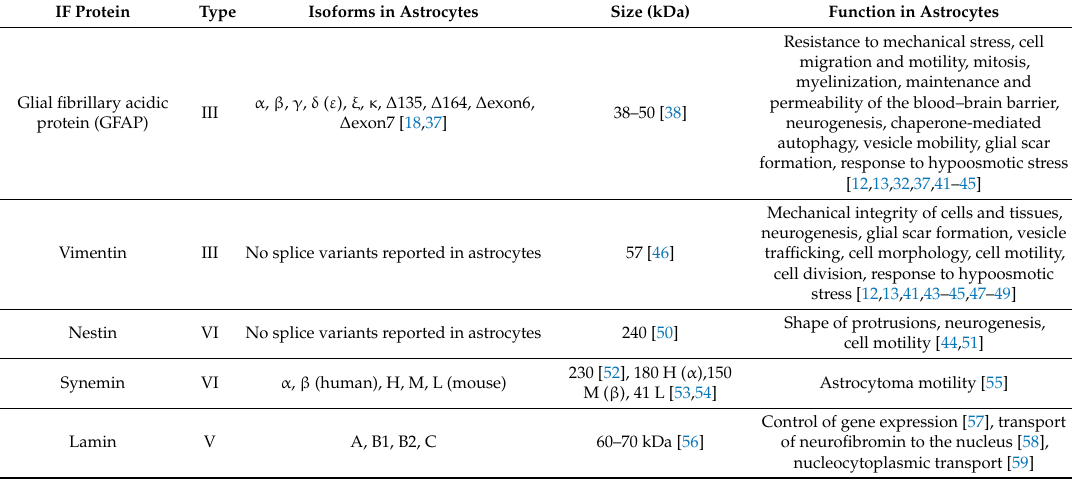
Table 1. Astrocytes express five types of IF proteins. GFAP and vimentin isoforms are splice variants of a single gene and lamin isoforms are encoded by di ff erent